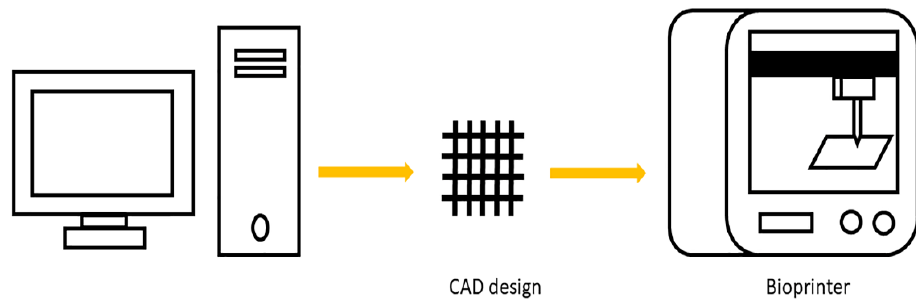
Figure 1. Three-dimensional printing process.